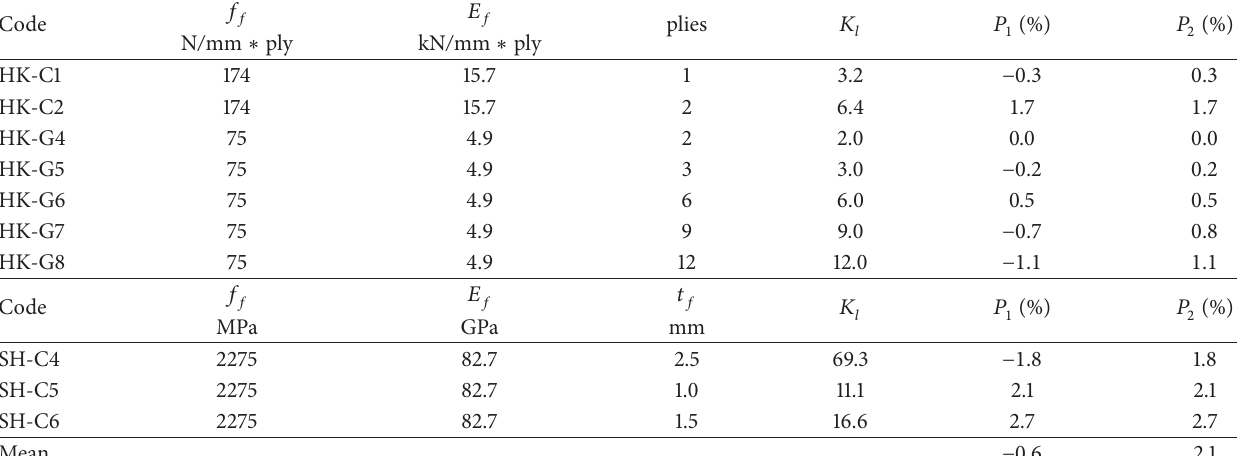
Table 1: Mechanical and geometrical characteristics of specimens considered in Figures 5 and 6 and evaluation of error 𝑃 𝑖 (%) of SAm in prediction of curve 𝑓 󸀠 𝑐 − 𝜀 𝑐 with experimental data.